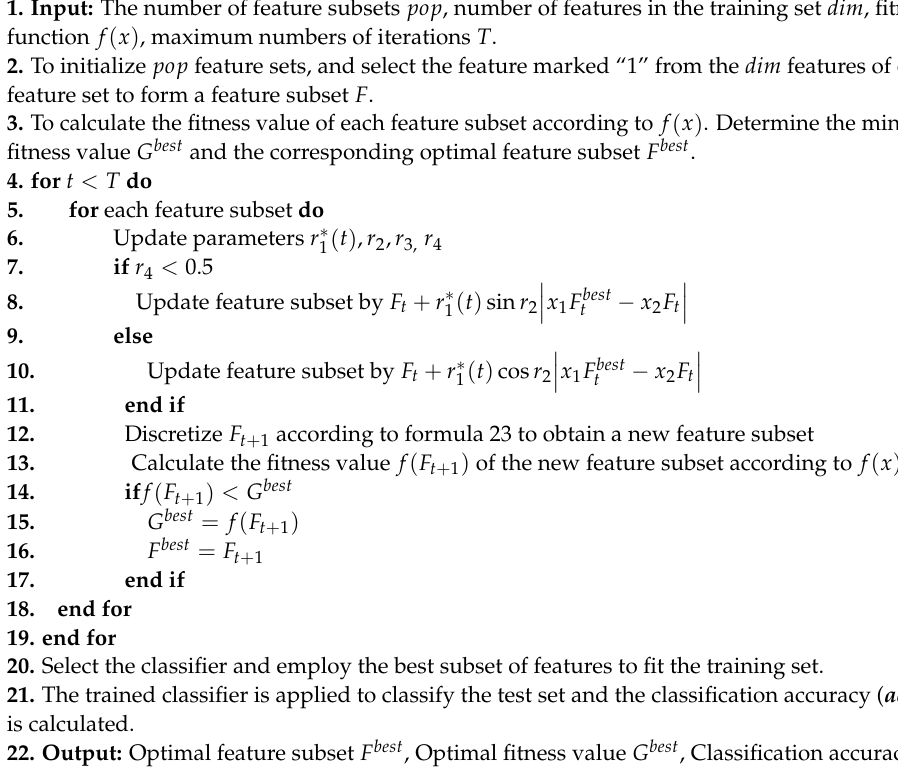
Algorithm 2 The MetaSCA_process for feature